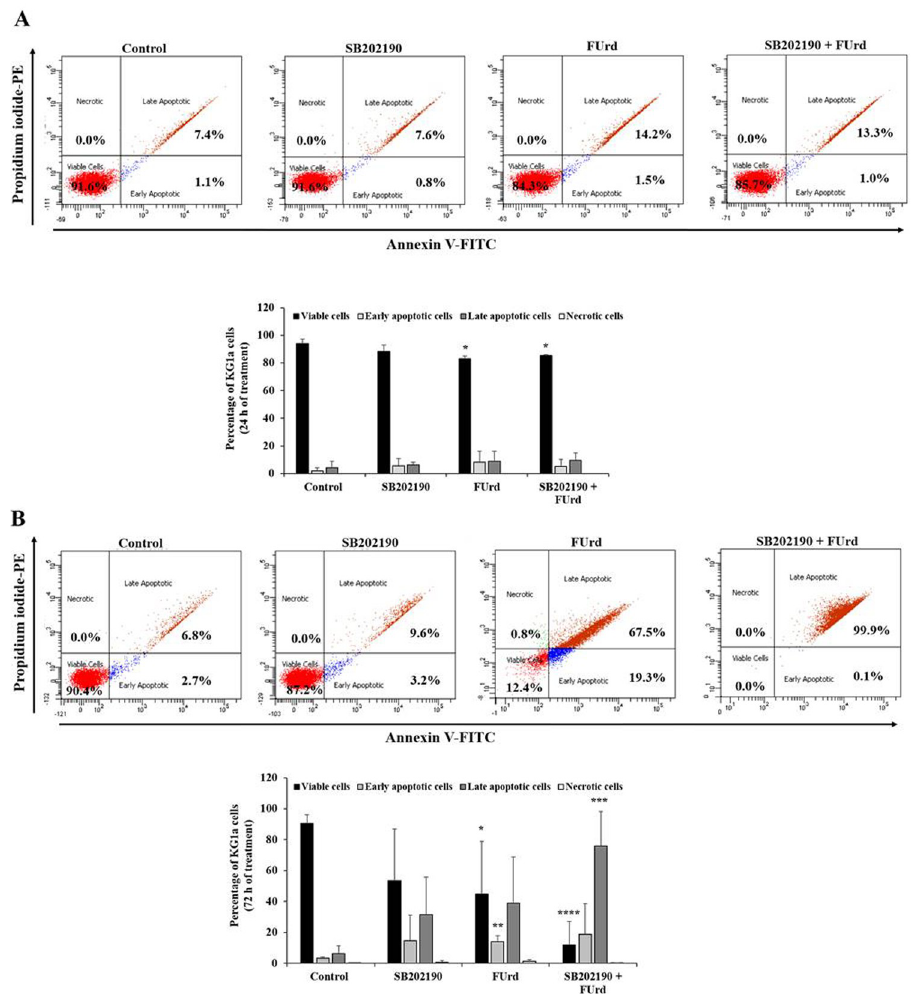
Fig 5. Analysis of apoptosis status in KG1a cells in response to 24-h (A) and 72-h (B) treatment with FUrd after cell pretreatment with SB202190. The KG1a cells were non-treated, treated with pharmacological inhibitors for 2 h incubation prior to cell treatment with 10 μ M of FUrd. After 24 h (A) and 72 h (B) incubation, the cells underwent FITC-labeled Annexin V/PE-labeled PI double-staining for apoptosis analysis using FACS. The numbers within the scatter plots represent the percentage of viable (lower left, Annexin V - /PI - ), early apoptotic (lower right, Annexin V + / PI - ), late apoptotic (upper right, Annexin V + /PI + ), and necrotic cells (upper left, Annexin V - /PI + ). The bar graphs present the percentage viable, early apoptosis, late apoptosis and necrosis of SB202190-pretreated KG1a cells in the presence or absence of 10 μ M FUrd along with the non-treated (control) cells, based on at least three independent experiments. The results are presented as mean ± SD. � p < 0.05, �� p < 0.01, ��� p < 0.001, and ���� p < 0.0001 vs .